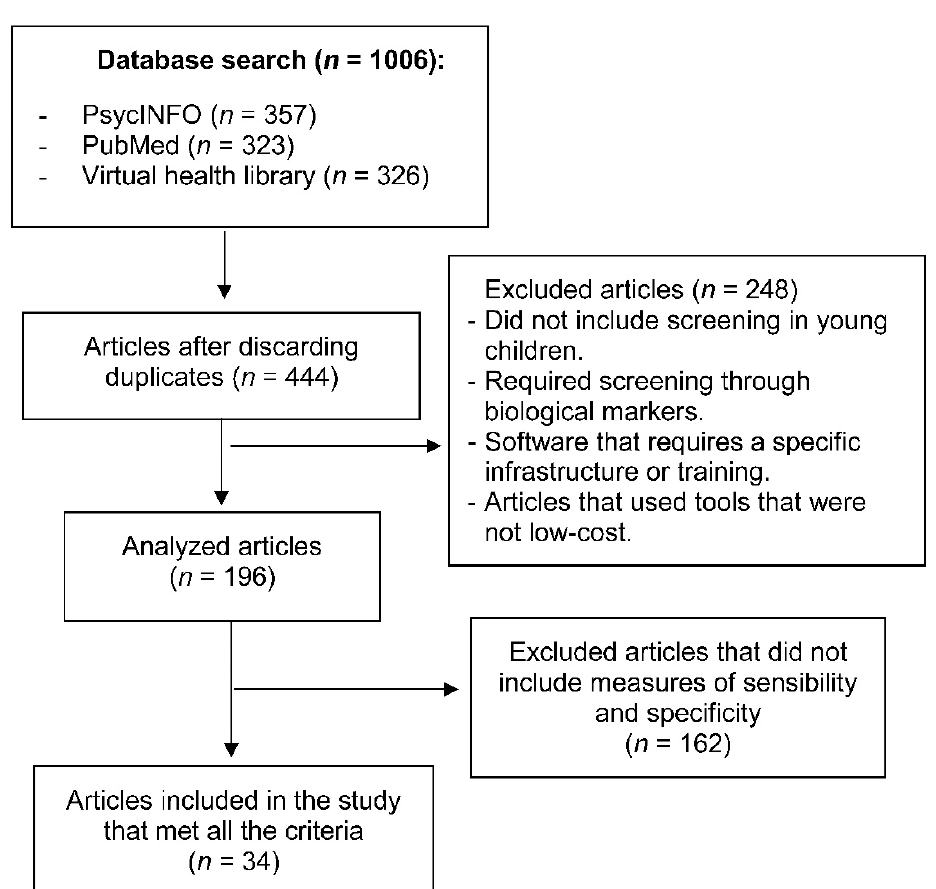
Figure 1. Schematic of the systematic review which includes the steps taken to collect all the studies included in the review.